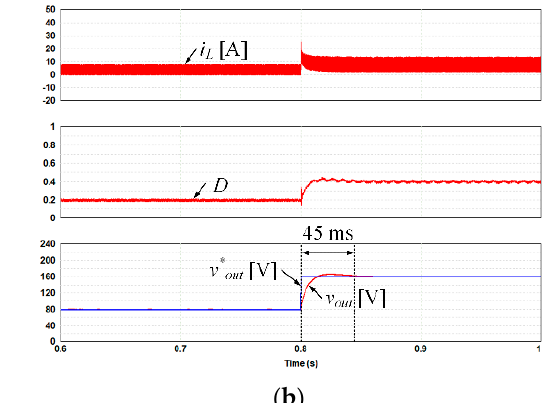
Figure 11. Simulation results of output voltage control of integrated OBC using the proposed MPC method. Figure 12 shows the simulation results of output voltage control of integrated OBC when the load impedance is abruptly changed (a) without a feedforward component of output power and (b) with a feedforward component of output power. It indicates i L , P out ,